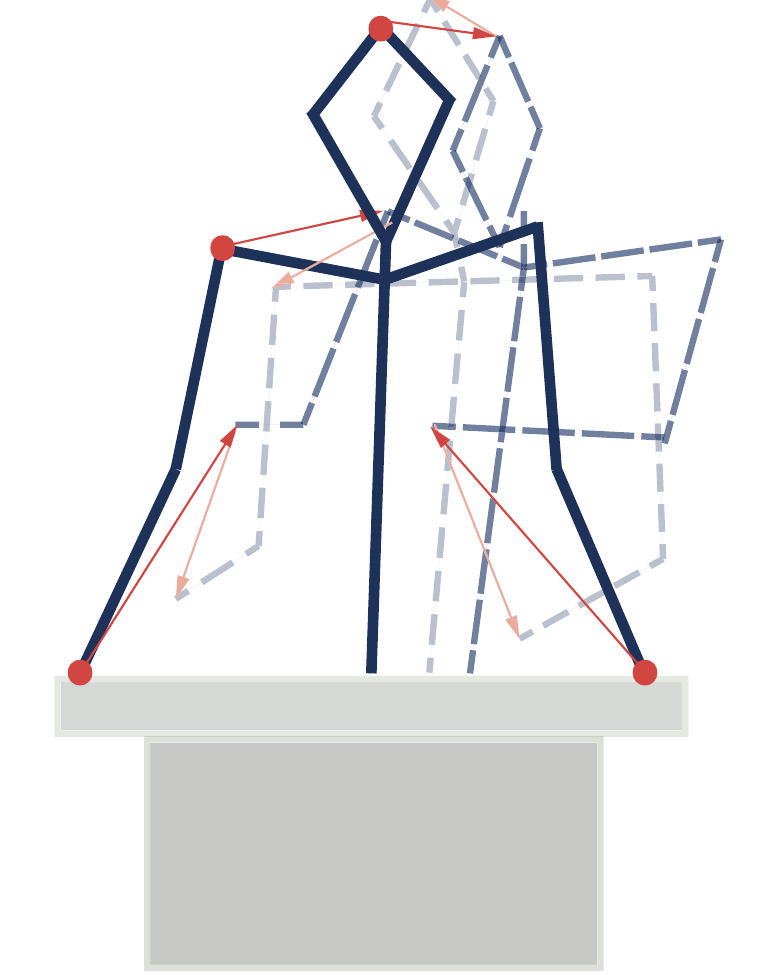
Fig 1. Landmark-positions of Stick-figure Stimuli at Different Points in